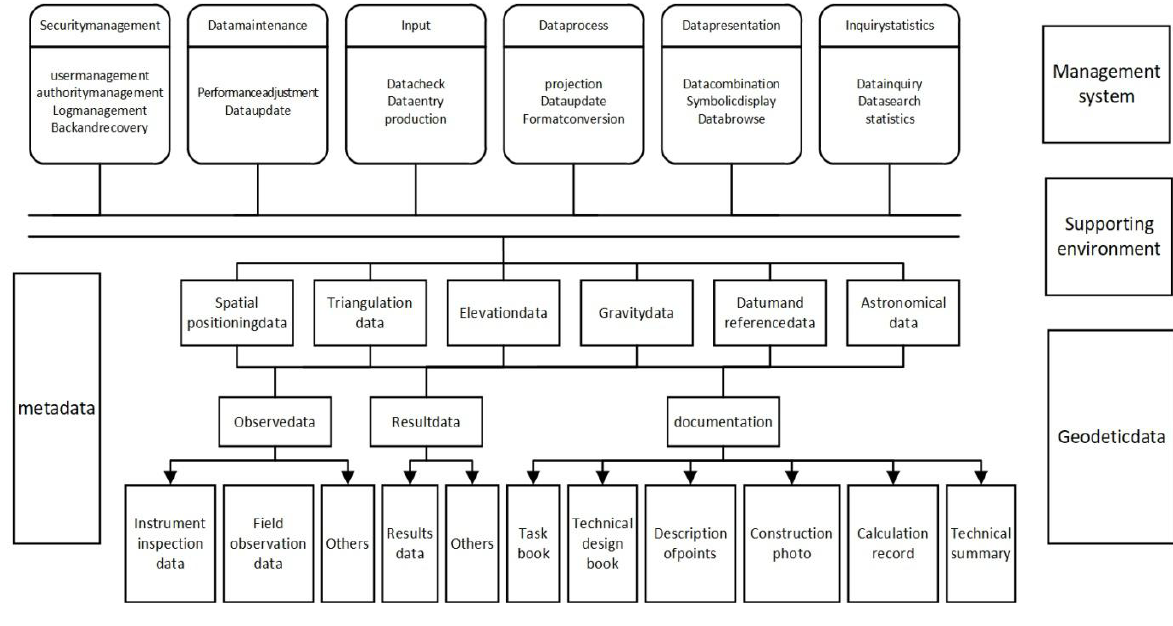
Figure 4, Geodetic Database